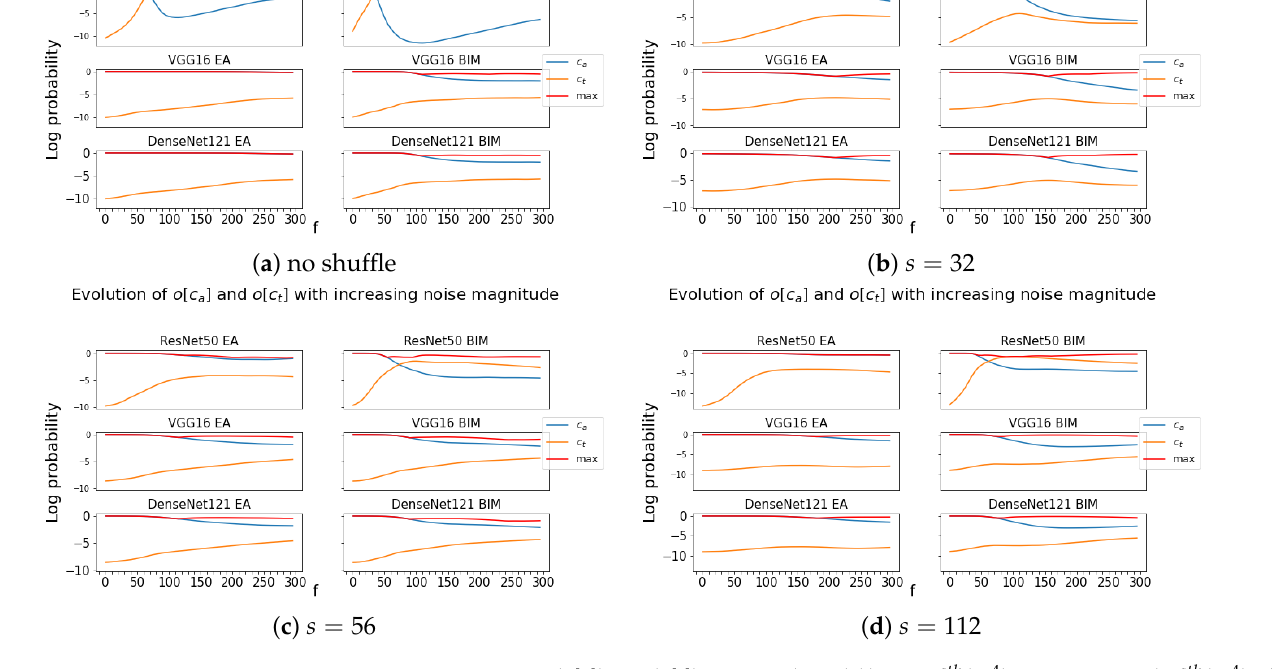
Figure 7. Evolution of log ( o [ a ]) , log ( o [ t ]) , and log ( max ( o )) for D atk for s = 32 ( b ), s = 56 ( c ) and s = 112 ( d ) when fed to C 6 , C 9 , and C 1 (first, second, and third rows of each set of graphs, respectively), when the noise is impacted by a factor f ∈ [ 0%,300% ]